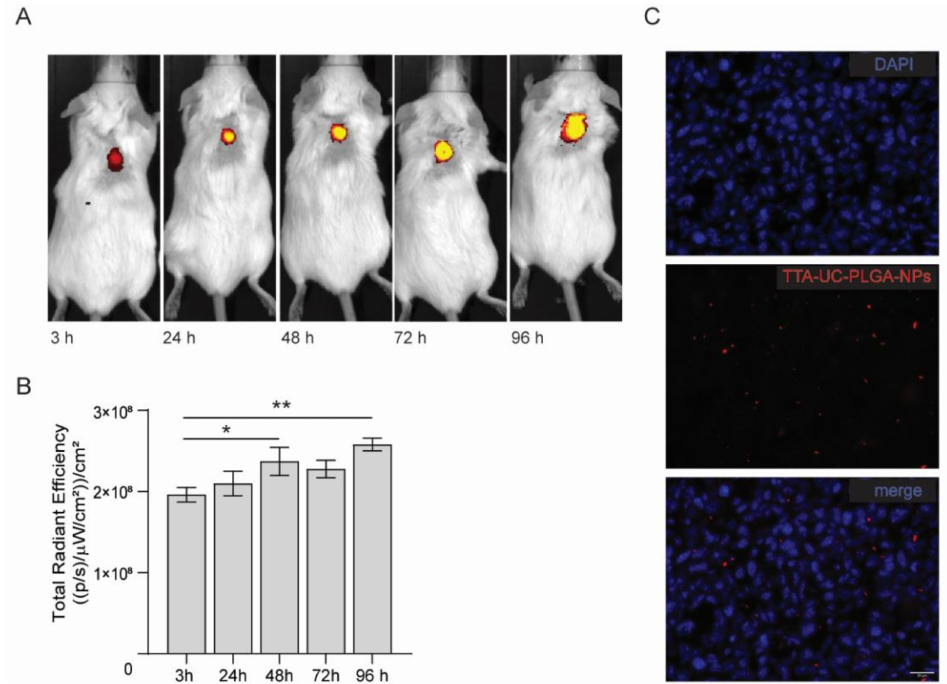
Figure 8. In vivo imaging of TTA-UC-PLGA-NPs. ( A ) FVB mice were inoculated in the back with 1 × 10 6 MCF-7 cells. When the tumours reached a size of 125 mm 3 , mice were injected intravenously in the tail vein with 0.5 mg of TTA-UC-PLGA-NPs and imaged 3, 24, 48, 72 and 98 h post injection using the IVIS imaging system. ( A ) TTA-UC-PLGA-NPs were excited at a wavelength of 535 nm, and the emission (phosphorescence) was collected at 640 nm. ( B ) The total radiance efficiencies were calculated in the tumour areas, and the values were compared. Statistical analysis was performed using the Mann–Whitney test, * p = 0.026, ** p = 0.0022 (6 mice per group were used). ( C ) MCF- tumours were excised 96 h post injection of TTA-UC-PLGA-NPs and tumour cryosections were imaged by fluorescent microscopy. The following filter cubes were used to discriminate DAPI (blue) and TTA-UC-PLGA-NPs (red) signals: DAPI, λ exc = 340–380 nm and λ emi = 425 nm; TTA-UC-PLGA- NPs, λ exc = 542–582 nm, λ emi 604–644 nm. Scale bar = 20 µ